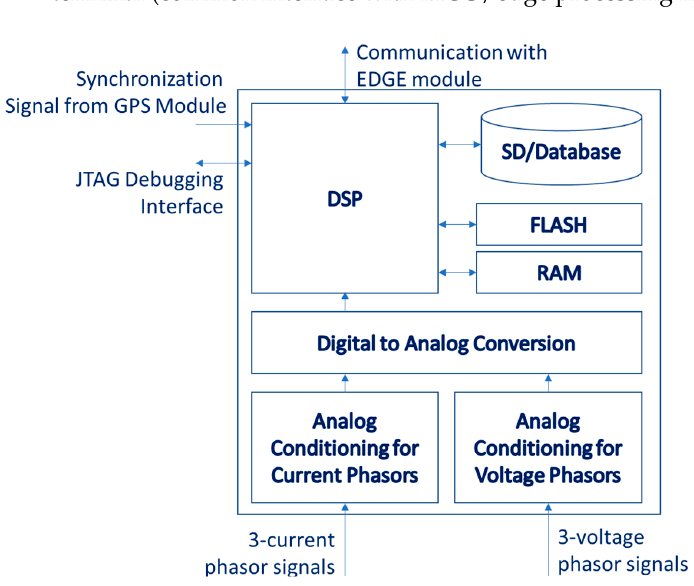
Figure 2. High-level architecture of the DSP module.